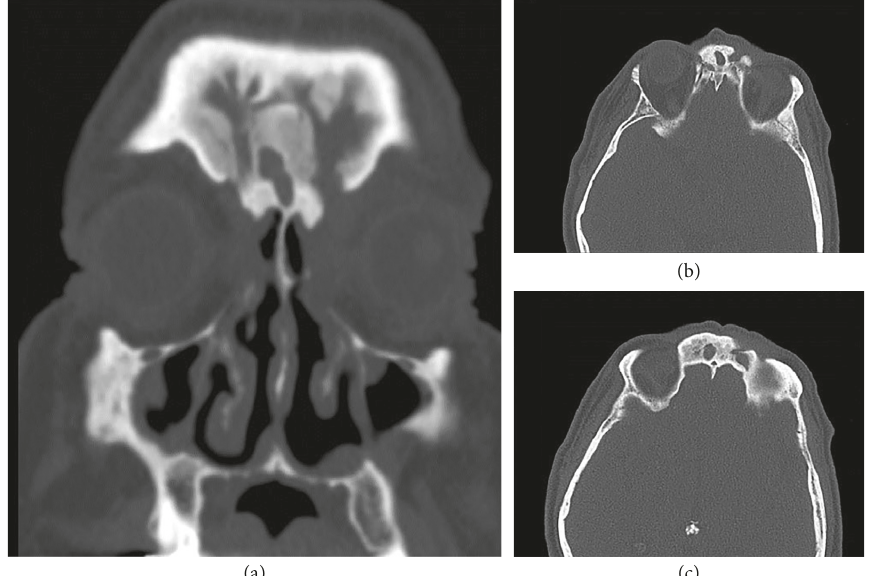
Figure 2: CTorbit, sinuses, and skull base. Small A-P diameter of frontal sinus with extensive neo-osteogenesis secondary to chronic frontal